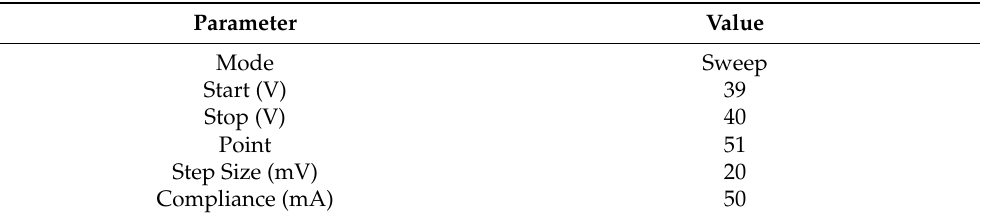
Table 1. Selective annealing conditions for dielectric breakdown.